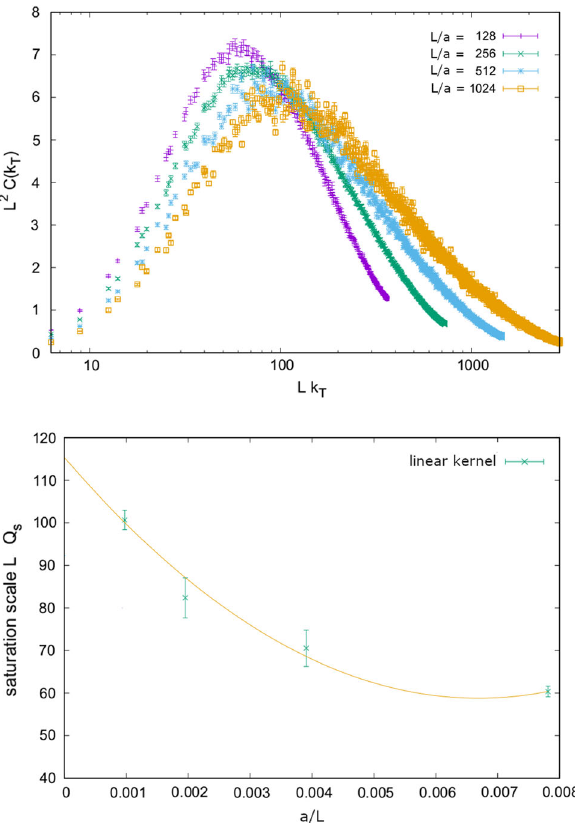
Fig. 9 Top: Dependence of the evolved two-point correlation function at s = 0 . 04 on the Langevin step δ s for the L / a = 128 lattice, using the momentum space implementation of the evolution equation. Bottom: Dependence of the saturation scale determined from the data sets show in the top panel on the Langevin time step δ s . Constant and linear extrapolationstothevanishingstepsizeareshown(notethelogarithmic scale on the x-axis). For step sizes smaller than δ s = 0 . 0001, data at finite values of the time step are compatible with the extrapolatedvalues